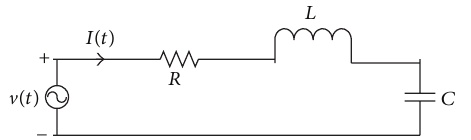
Figure 2: Illustration of RLC resonance circuit in series.